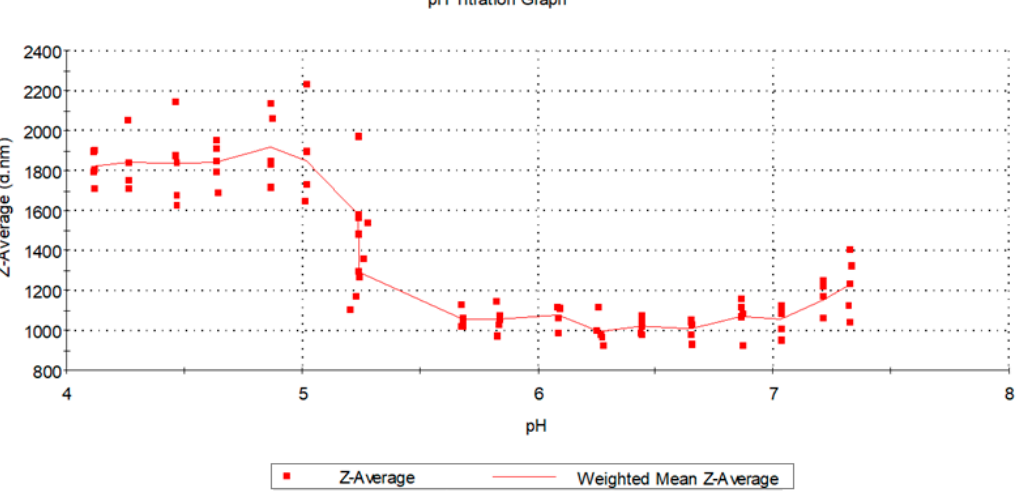
Figure 3. pH titration graph (in the range from 4.2–7.4) for SWNT-CR-DOX—Weighted Mean Intensity of Z-Average.